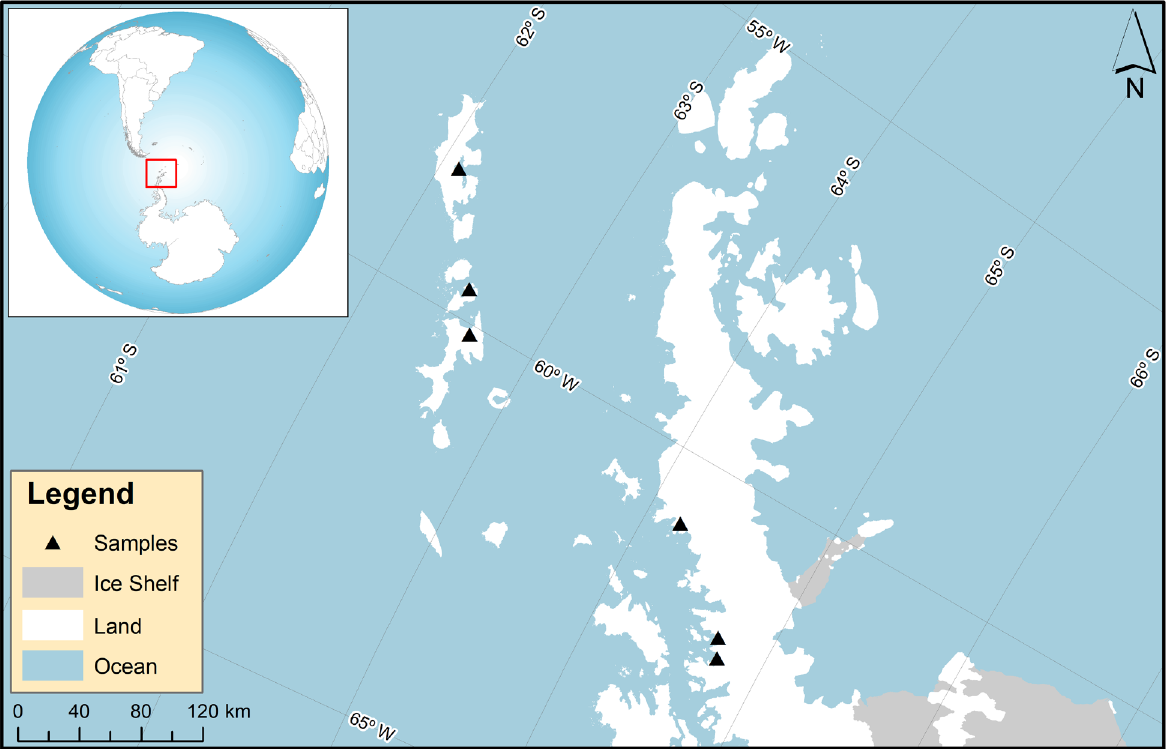
Figure 1. Map showing the sampling locations in the South Shetland Islands, KGI = King George Island, Grw = Greenwich Island, Livin = Livingston Island, Pen1 = Antarctic Peninsula 1, Pen2 = Antarctic Peninsula 2, Arctow = Arctowski Table I. Sites were glacial ice was sampled in South Shetland Islands and Antarctic Peninsula. Glacier